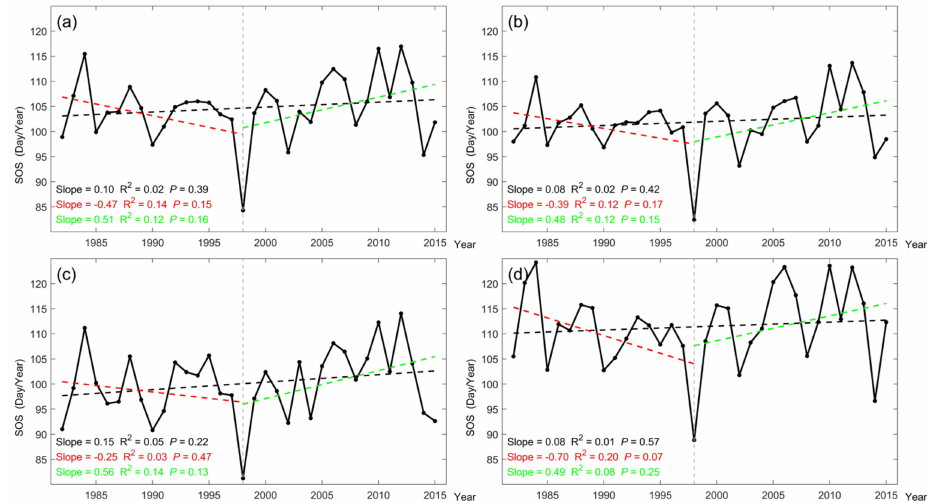
Figure 3. The inter-annual variation trend of SOS from 1982 to 2015. ( a ) China–DPRK–Russia cross- border area. ( b ) China side. ( c ) North Korean side. ( d ) Russian side. (The black solid black line represents the SOS annual series from 1982 to 2015, the red dashed line represents the interannual change trend from 1982 to 1998, and the green dashed line represents the inter-annual change trend from 1998 to